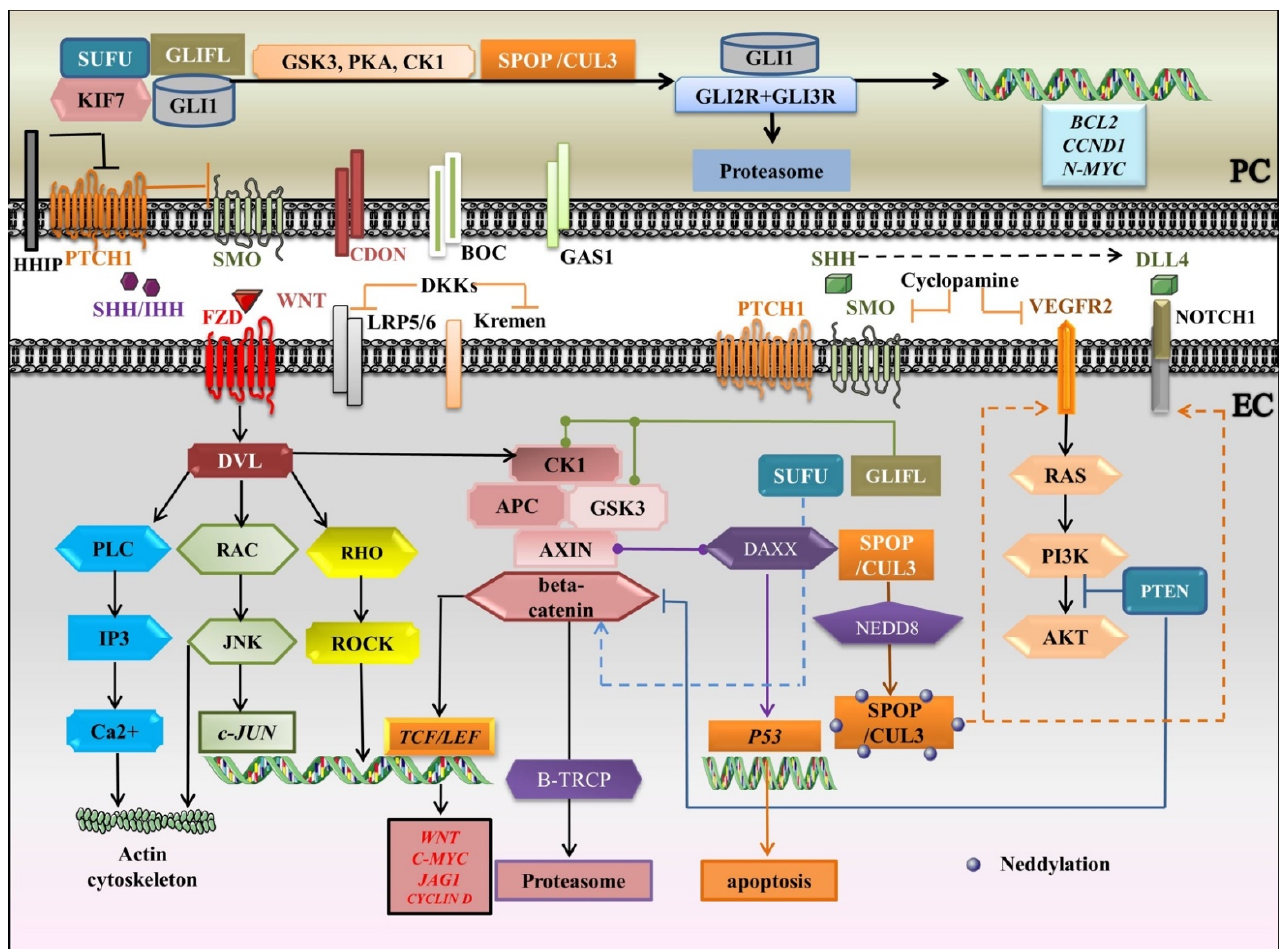
Figure 3. A schematic portrayal of crosstalk between HH, WNT, VEGF, and NOTCH signaling pathways. APC: Adenomatous polyposis coli; BOC: Brother of CDON; CK1: casein kinase1; CUL3: Cullin 3; DAXX: Death-domain associated protein; DKKs: Dickkopfs; DLL: Delta-like; DVL: Dishevelled; EC: endothelial cell; FZD: Frizzled receptor; GAS1: Growth arrest specific 1; GLIFL: Gli full-length; GSK3: glycogen synthase kinase-3; HHIP: HH interacting protein; HH: Indian hedgehog; IP3: Inositol 1, 4, 5-trisphosphate; JAG: Jagged; JNK: c-JUN N-terminal kinase; KIF7: Kinesin family member 7; LRP5/6: Lipoprotein receptor-related proteins 5/6; PC: pericyte; PCP: planar cellpolarity; PI3K: Phosphatidylinositol 3-kinase; PKA: protein kinaseA; PLC: Phospholipase C gamma; PTCH1: Patched1 receptor; PTM: post-translational modification; ROCK: RHO-associated protein kinase; SHH: Sonic hedgehog; SMO: Smoothened; SPOP: BTB/POZ protein; SUFU: Suppressor of fused; TCF/LEF: T-Cell factor/Lymphoid enhancing factor; UBE3: E3 ubiquitin ligase; VEGFR2: Vascular Endothelial Growth Factor Receptor 2; black arrows: main signaling pathways; blunt-ended lines: blockade/inhibition, dashed arrows: induction/activation, round-ended lines: association. Segments of the figure were sketched by using artworks from Servier Medical Art (15 November 2021). Servier Medical Art by Servier is licensed under a Creative Commons Attribution 3.0 Unported License, https://creativecommons.org/licenses/by/3.0/ (access on 15 November